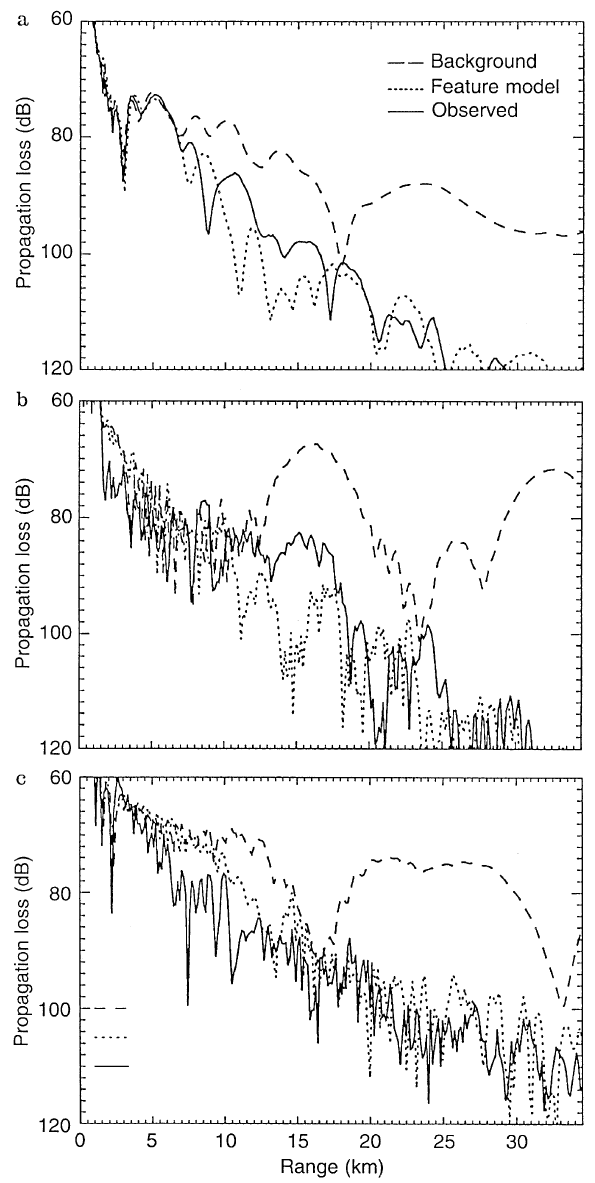
Fig. 11a (cid:177) c. Propagation-loss values obtained through the frontal environment: a frequency 50 Hz, source and receiver depth 50 m; b frequency 400 Hz, source and receiver depth 50 m; c frequency 400 Hz, source depth 50 m and receiver depth 150